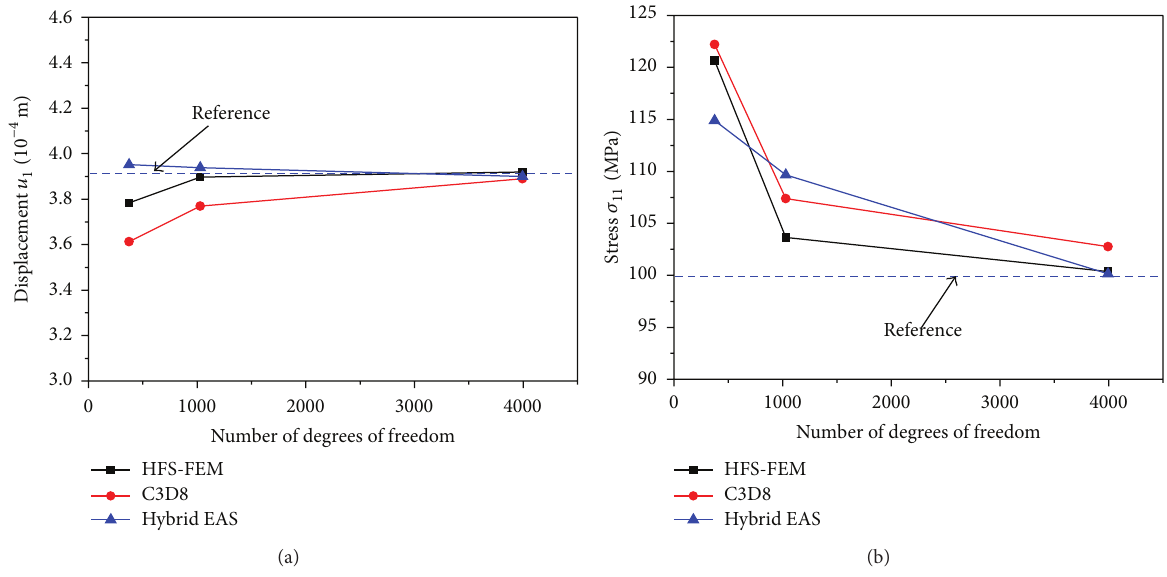
Figure 9: Cubic block with body force under uniform distributed load: convergent study of (a) displacement 𝑢 1 and (b) stress 𝜎 11 .